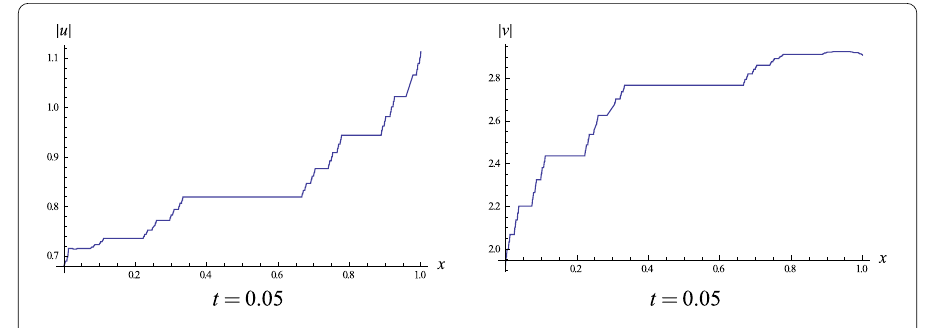
Figure 6 Profiles along the x axis of one-fractal solutions (91) with α =